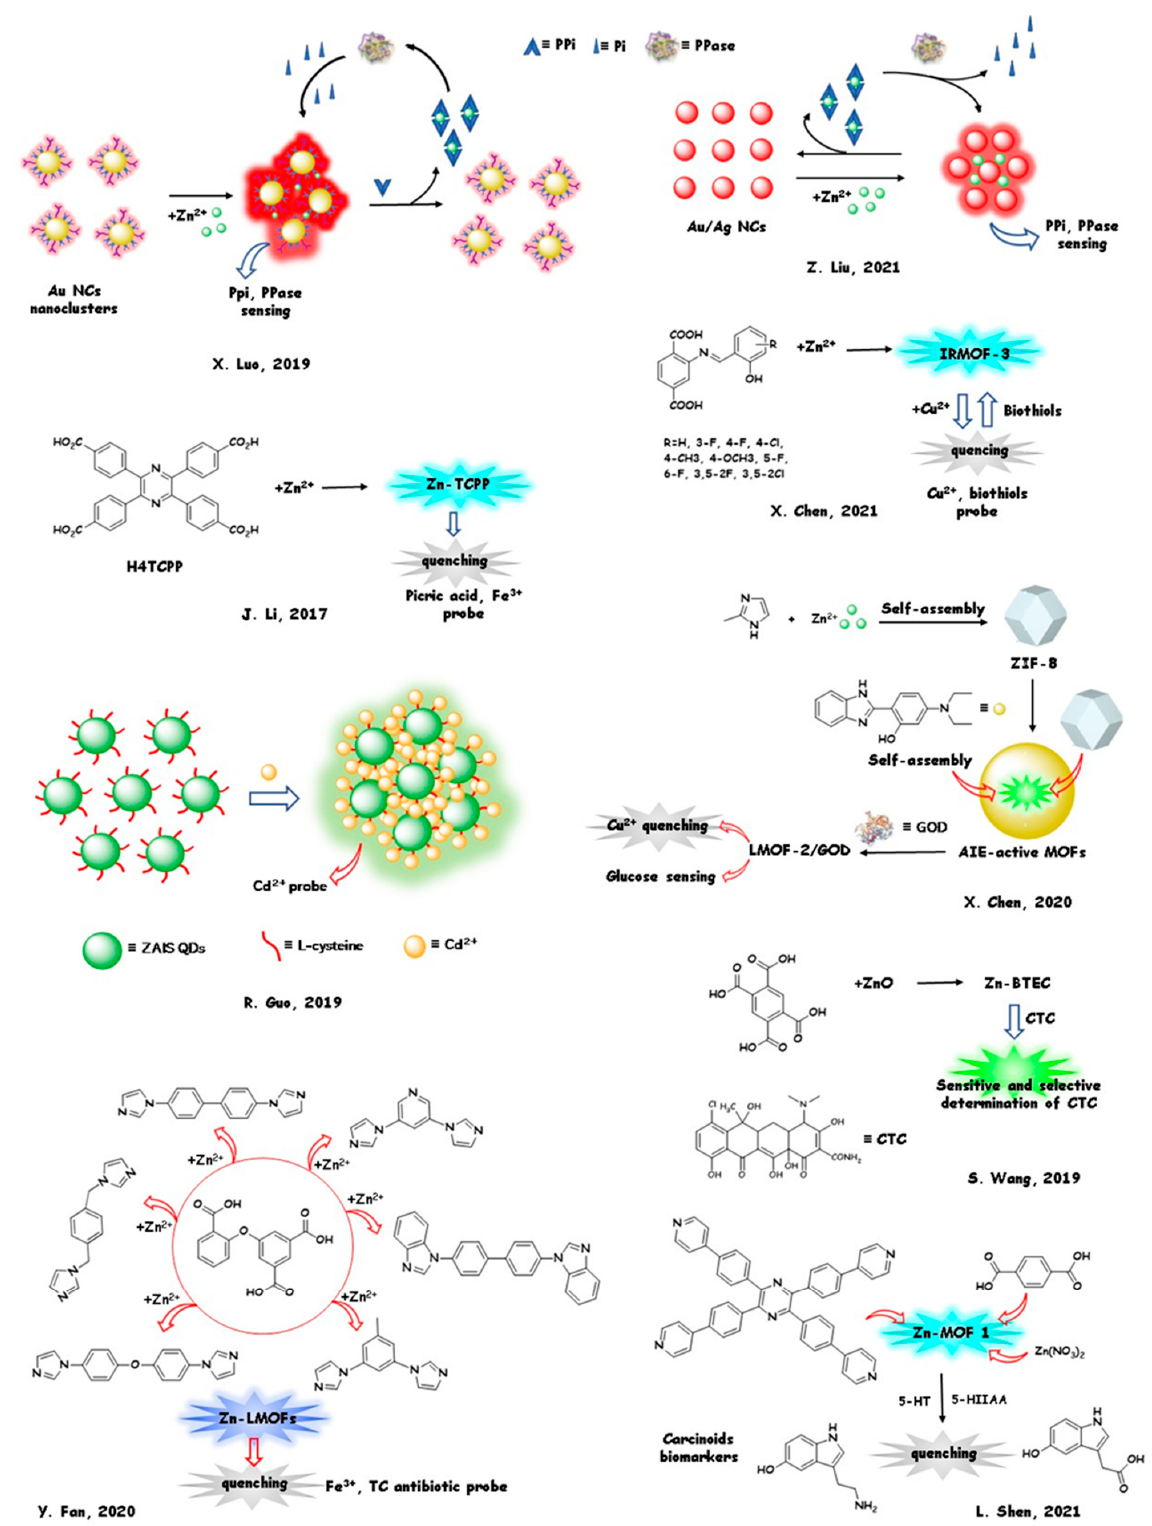
Figure 8. Structures and sensing mode of relevant nanosized Zn-AIEgens. Jiyang Li and coworkers in 2017 [149] produced a new rigid symmetric tetracarboxylic ligand 2,3,5,6-tetrakis(4-carboxyphenyl)pyrazine (H4TCPP) with AIE properties as a ligand for building the multifunctional Zn-TCPP MOF. The three-dimensional channel structure of Zn-TCPP displays bright blue luminescence in the presence of CO 2 and a quenching